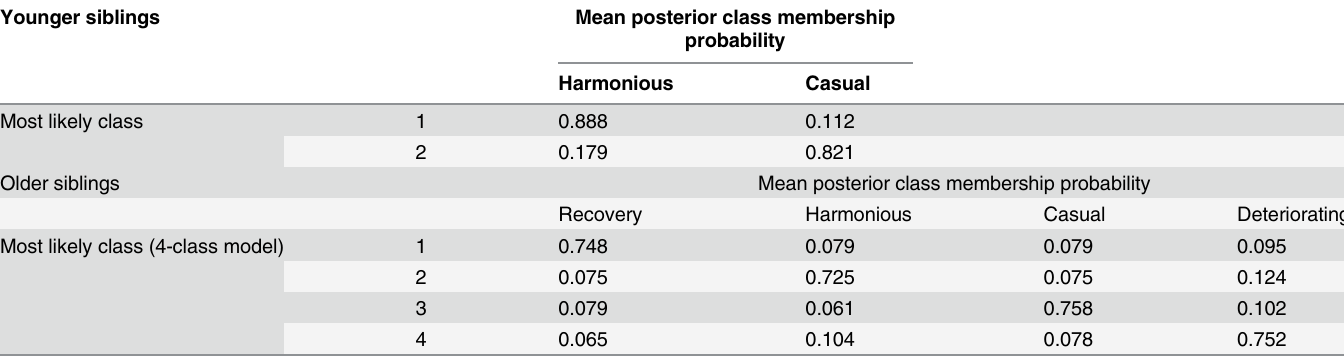
Table 2. Mean Posterior Class Membership Probabilities for Younger and Older Siblings by Most Likely Class.